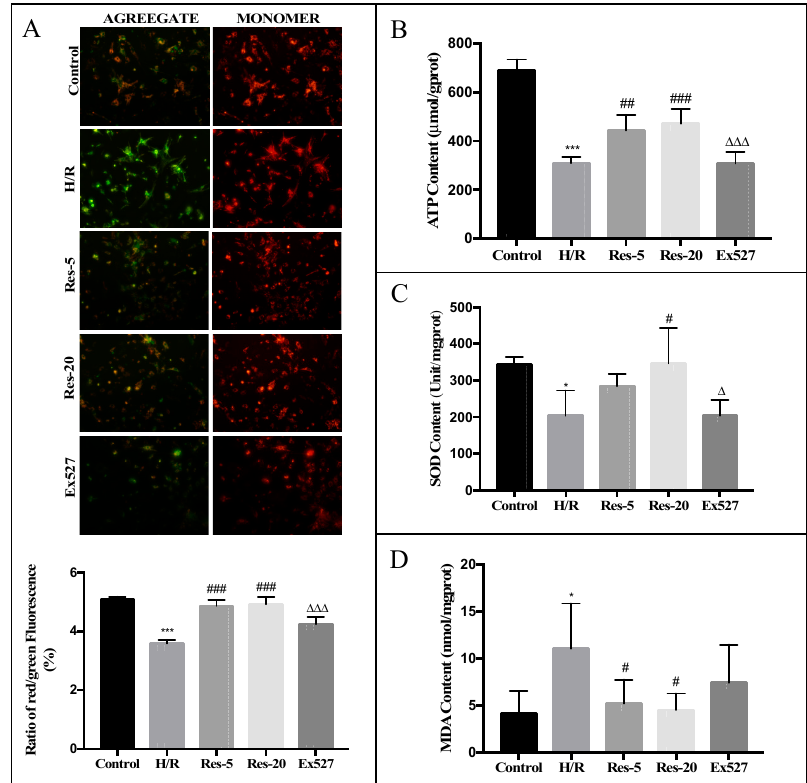
Figure 1. Resveratrol treatment improves stability of ∆ Ψ m , ATP content, SOD content and MDA content in neonatal rat cardiomyocytes undergoing H/R, while this effect was abrogated by EX527. The cardiomyocytes were pretreated with resveratrol at doses of 5 or 20 µ M and resveratrol combined with Ex527 (1 µ M) treatment exposed to hypoxia for 12 h and reoxygenation for 12 h. ( A ) Mitochon- drial membrane potential ( ∆ Ψ m ) was determined by JC-1 dye, observed by inverted fluorescence microscope. Red aggregate emission profile represents the JC-1 probe accumulates in healthy mito- chondria, whereas green emission represents mitochondrial injury and loss of membrane potential. The graph represents the ratio of red/green fluorescence. ( B ) ATP content was measured by inverted fluorescence microscope and microplate reader. ( C ) SOD content was measured by SOD detection kit-WST. ( D ) MDA content was measured by MDA test kit. Figures are representative images of three different samples. Results are expressed as mean ± S.D. * p < 0.05, *** p < 0.001 vs. control group; # p < 0.05, ## p < 0.01, ### p < 0.001 vs. H/R group; ∆ p < 0.05, ∆∆∆ p < 0.001 vs. Res-20